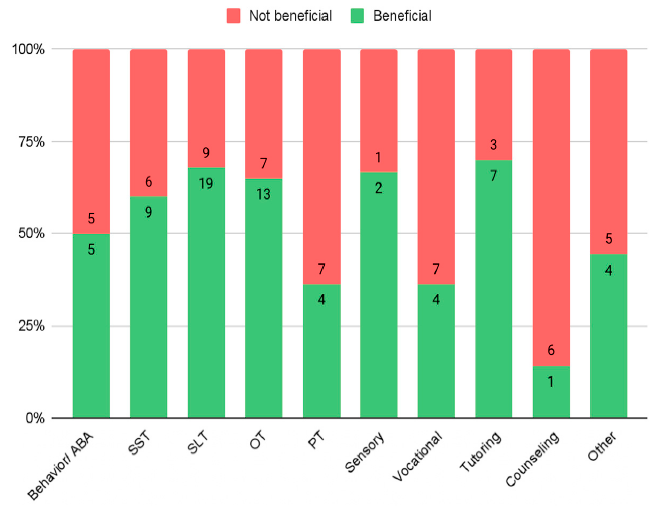
Figure 1. Proportion of how helpful each service was rated.